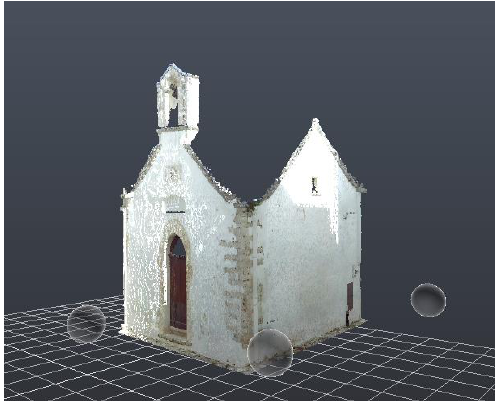
Figure 3. 3D model of the exterior of the church.